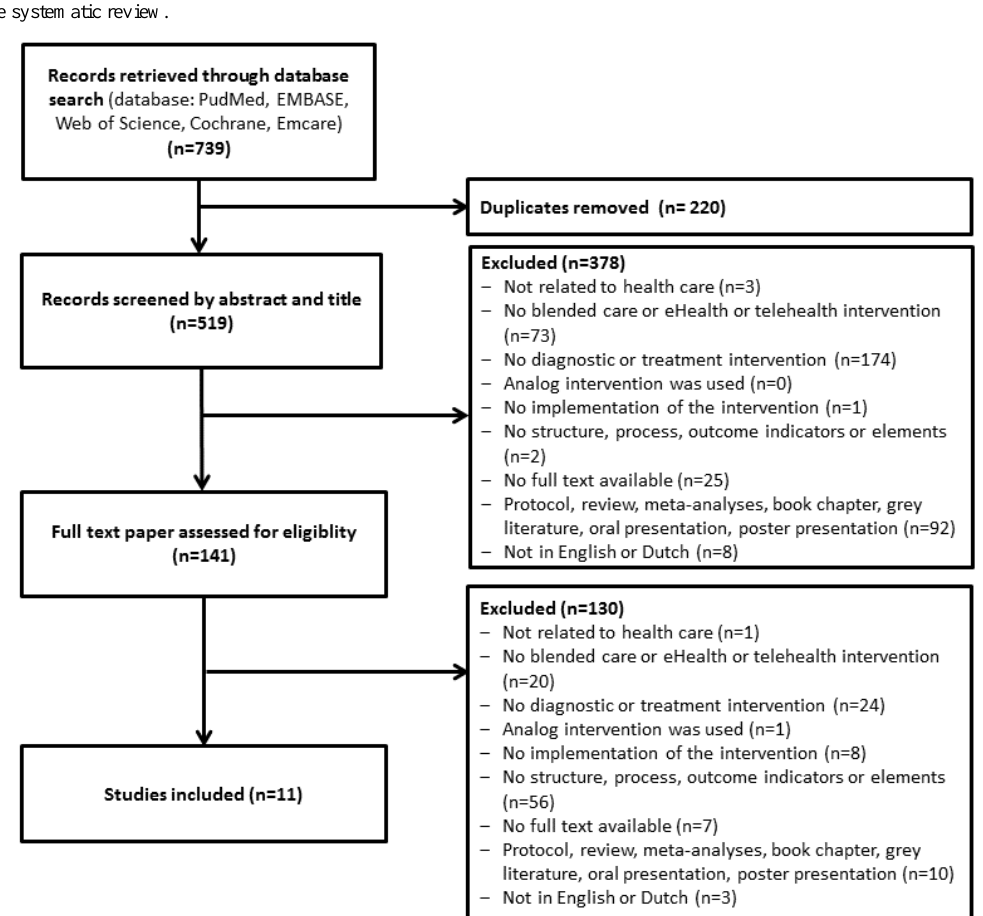
Figure 4. Flowchart of the systematic